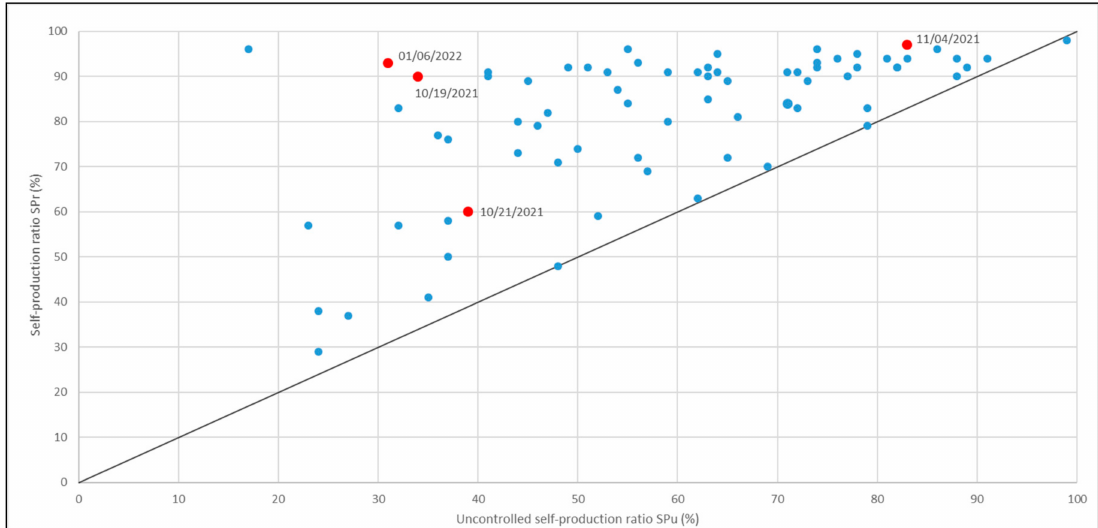
Figure 3. Distribution of the self-production ratio in both controlling scenarios on a scatter plot (red dots correspond to days that will be described in the next